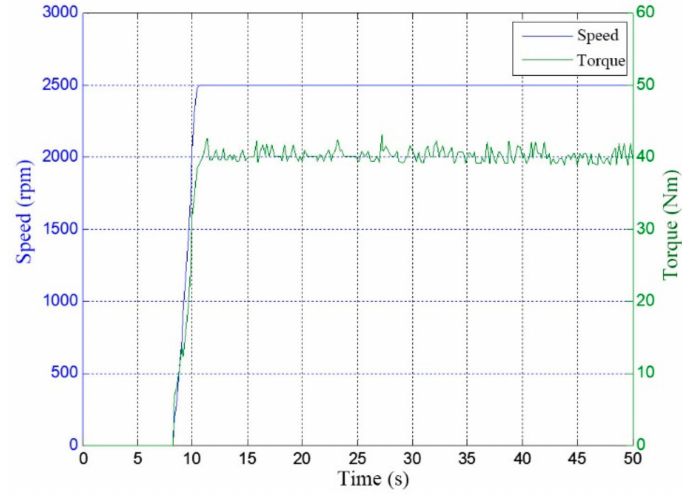
Figure 19. Non-loaded working condition.